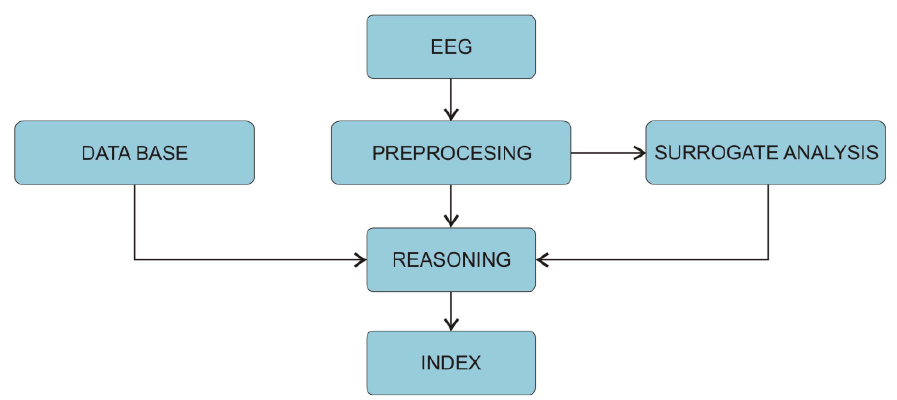
Figure 4. The conceptual diagram of a DGA